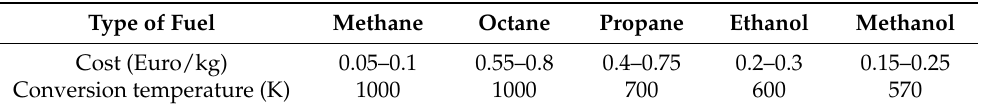
Table 1. Conversion temperature Tc and cost of the main alternative fuels that can be used in internal combustion